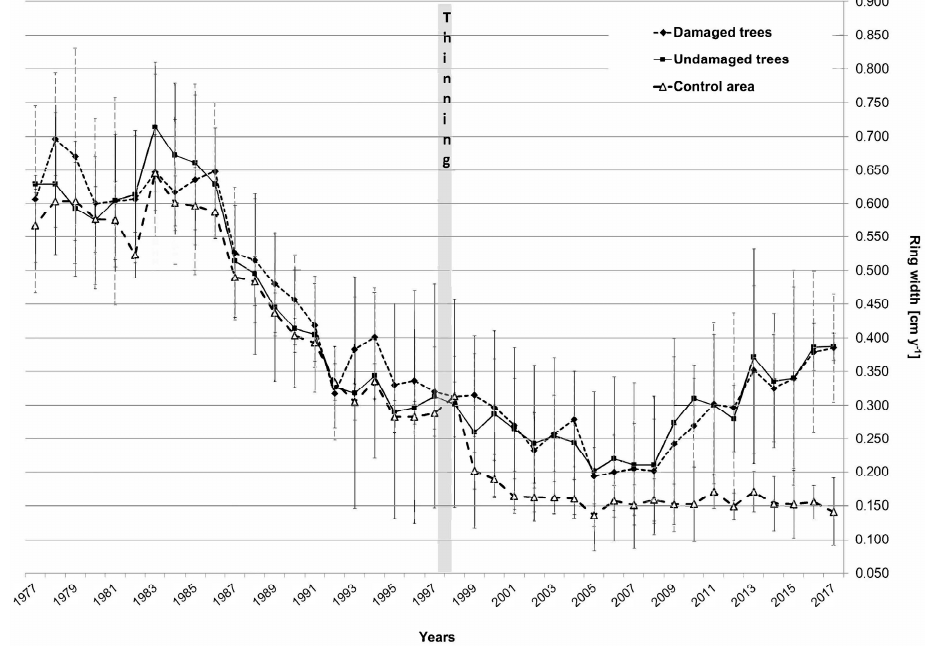
Figure 1. Trend of weighted yearly ring width (YWW) (i.e., the mean of yearly ring width weighted on the basis of the frequency distribution of trees per each diameter class in 2017) from ‘70s to 2017. The Wilcoxon non-parametric test showed significant differences after thinning, for the YWW between trees of the control area and damaged trees of the thinned area ( p -level 0.008). Similar results were obtained for trees of the control area and undamaged trees of the thinned area ( p -level 0.006). Furthermore, no statistically significant difference was exhibited after thinning between damaged and undamaged trees of the thinned area ( p -level 0.095).